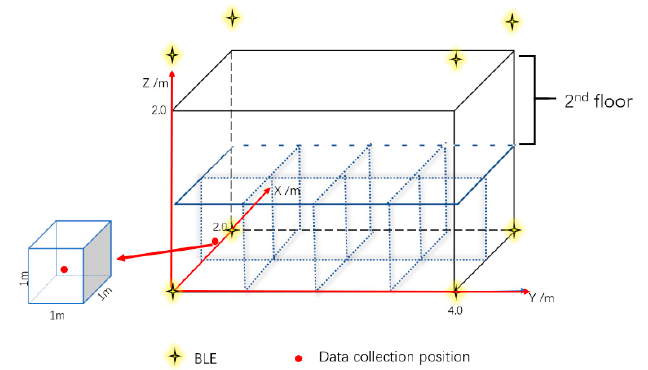
Figure 4. Division of positional spatial grids.